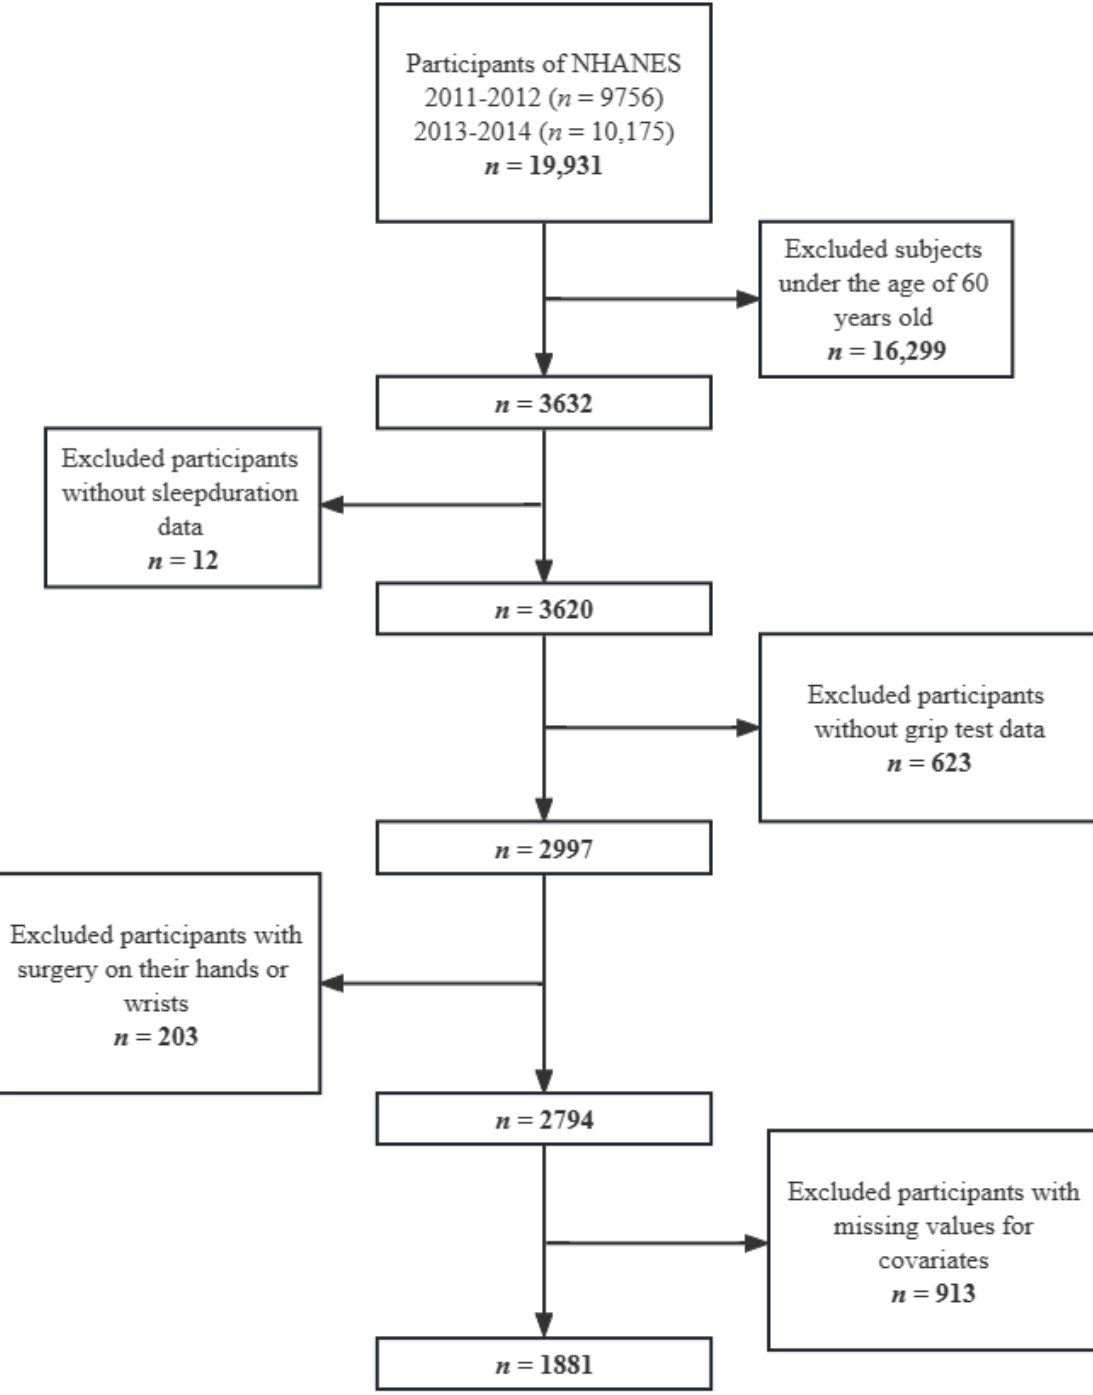
Figure 1. Flow chart of the screening process for the selection of eligible participants.